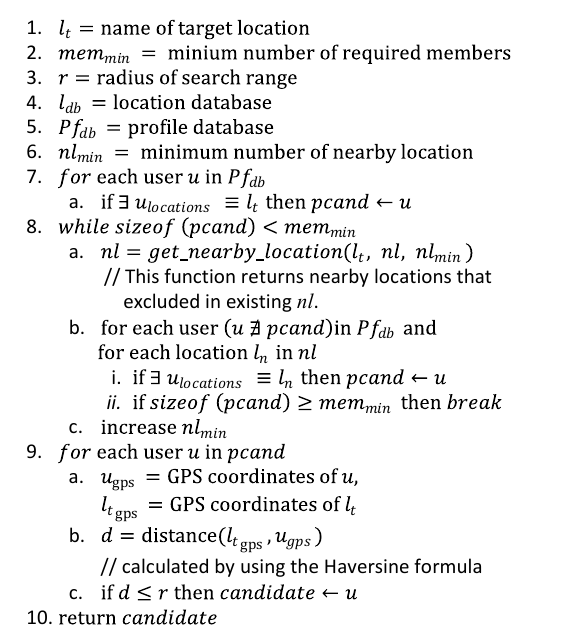
Table 2. Algorithm for location-based user